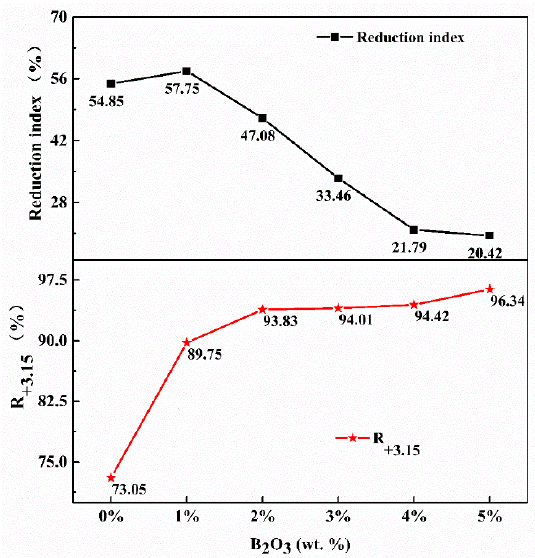
Figure 7. Metallurgical properties of sinter at B 2 O 3 addition.